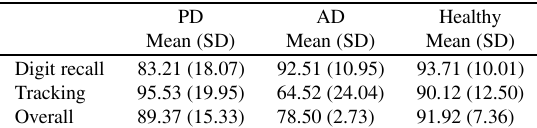
Table 2 Group means and standard deviations of proportional performance in digit recall ( p m), tracking ( p t) and both tasks overall ( µ